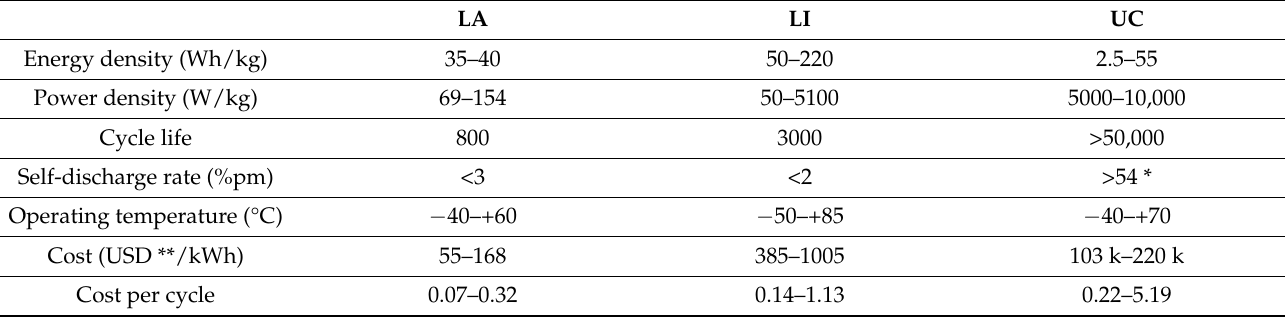
Table 5. Lead acid, lithium-ion and ultra-capacitor comparison, adapted from [24].